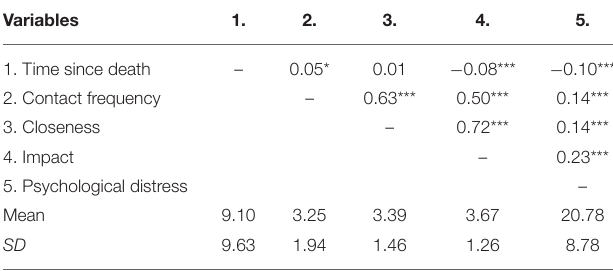
TABLE 1 | Intercorrelations among key study variables.